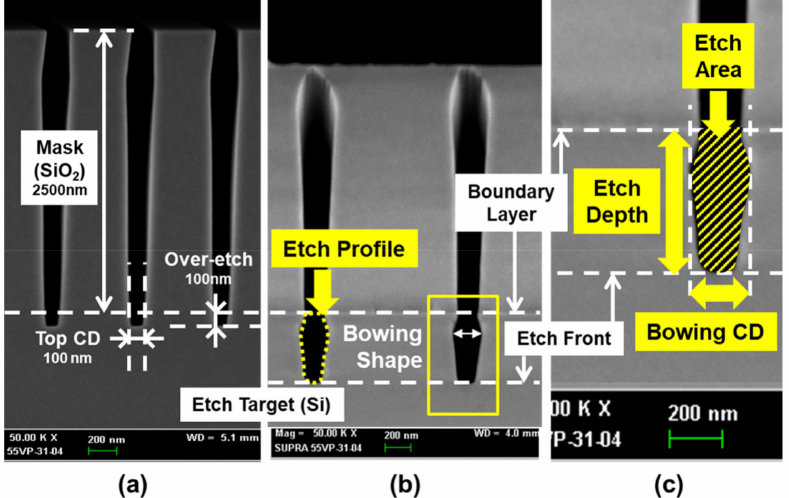
Figure 5. Definition of Si etch profile which is taken from a cross-sectional SEM image of Si with the SiO 2 mask. Etch depth, bowing CD, etch area of trench, and etch profile are defined. ( a ) SEM image before the Si etch process with the etched SiO 2 mask. ( b ) SEM image after the Si etch process. Yellow dotted line indicates etch profile. ( c ) Quantification of etch profile. Vertical position of etch front and SiO 2 /Si layer boundary are marked with white horizontal dashed lines. Etch depth, bowing CD, and etch area are marked with yellow